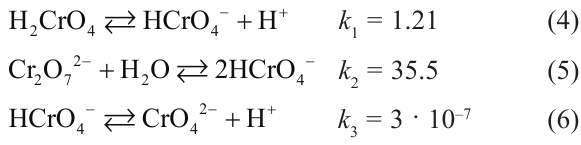
= 10 mg dm –3 , V = 100 0 0